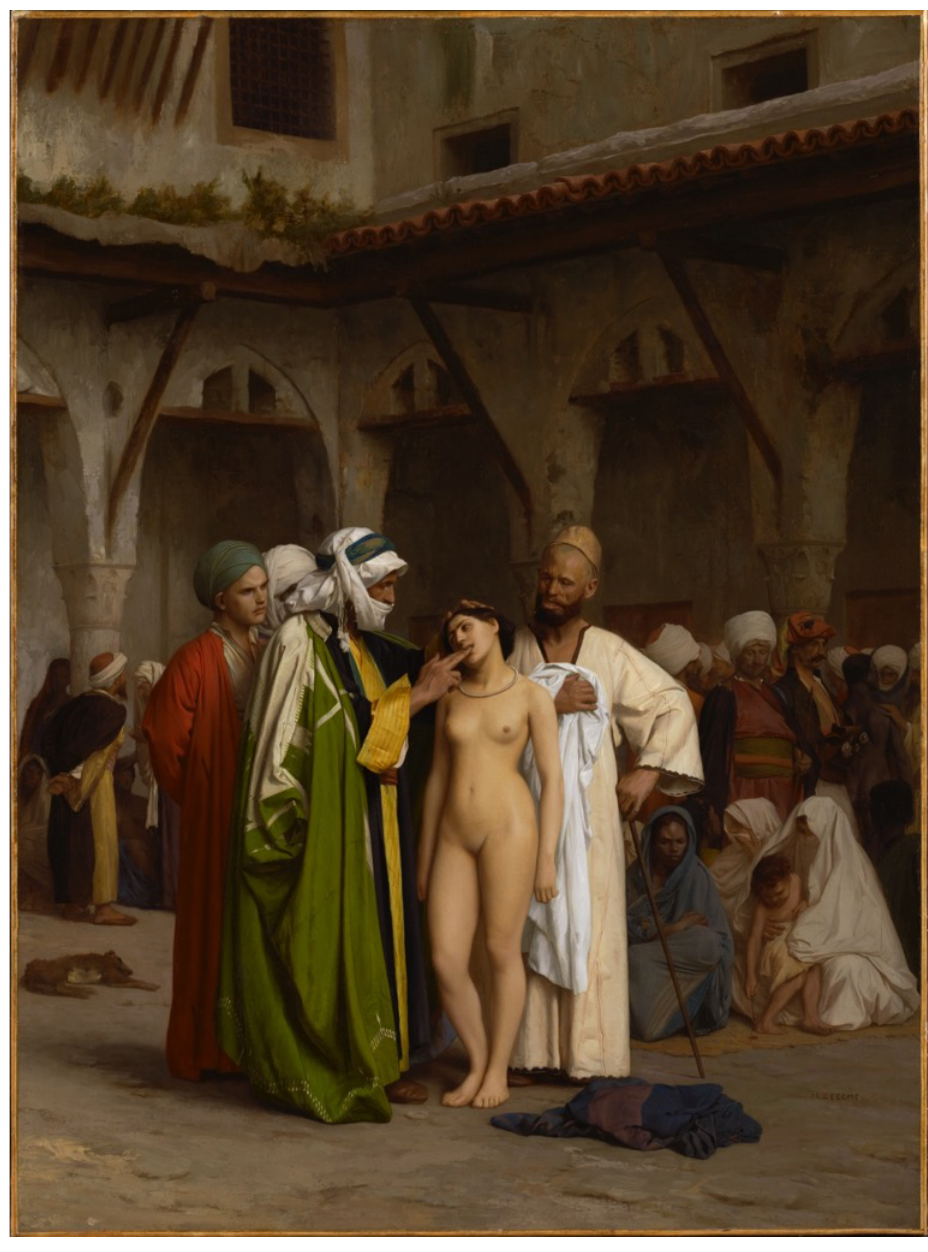
Jean-Léon Gérôme, Le Marché d’esclaves , 1866. Oil on canvas. 84.6 x 63.3 centimeters. Image courtesy of the Clark Art Institute, Williamstown, Massachusetts,